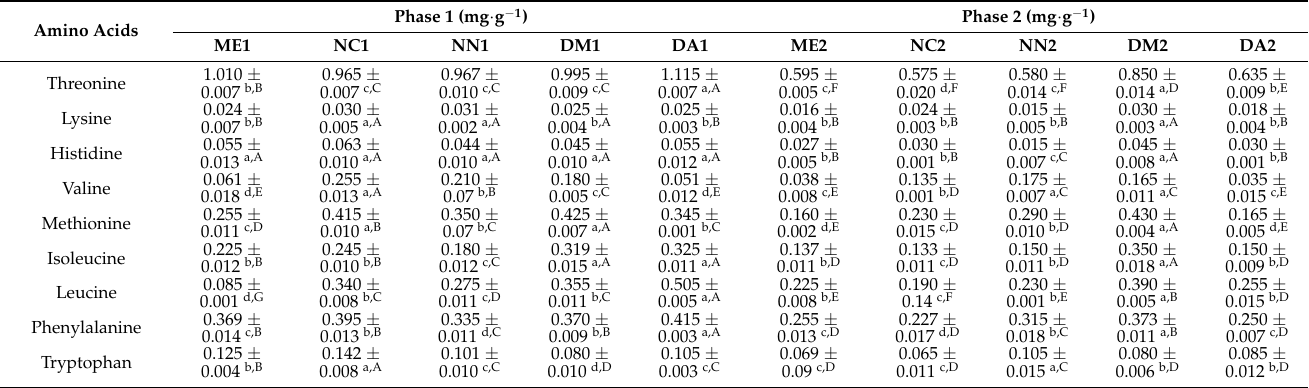
Protein digestibility values are displayed in Table 5. The AAS in this case was corrected for protein digestibility (PDCAAS) based on the amino acid requirements for children aged 0 to 12 months old. Even after correction, values remained lower than 1.0 for all phase 1 and phase 2 IFs, indicating that essential amino acid concentrations in the investigated IFs were under the recommended limits. Furthermore, almost all PDCAAS were higher in phase 1 compared to phase 2 IFs ( p < 0.01). Table 5. Protein digestibility-corrected by amino acid scores (PDCAAS) from phase 1 and phase 2 infant formulas calculated for children age 0–6 and 7–12